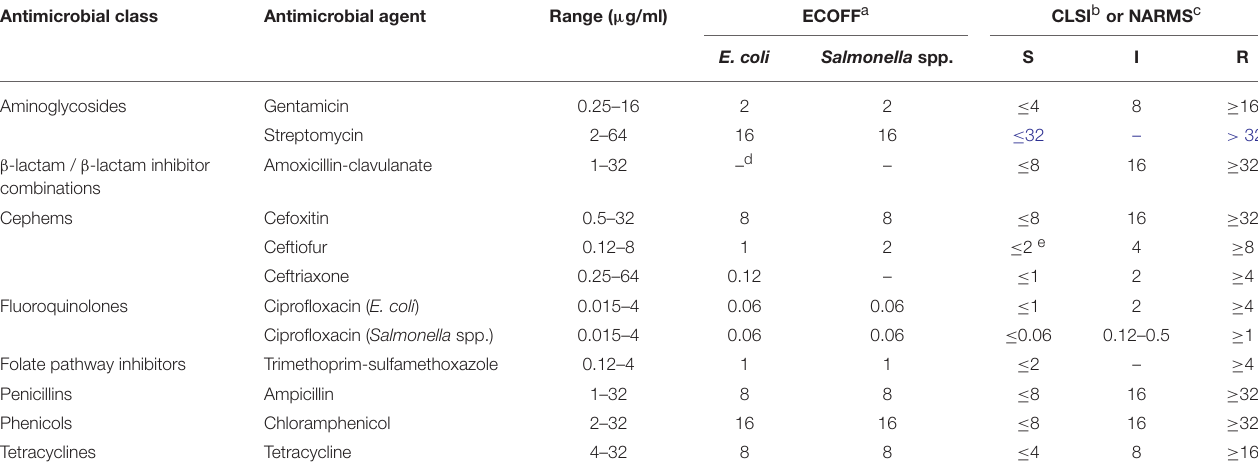
TABLE 1 | Breakpoints used for AST testing of E. coli and Salmonella spp. isolates. Antimicrobial class